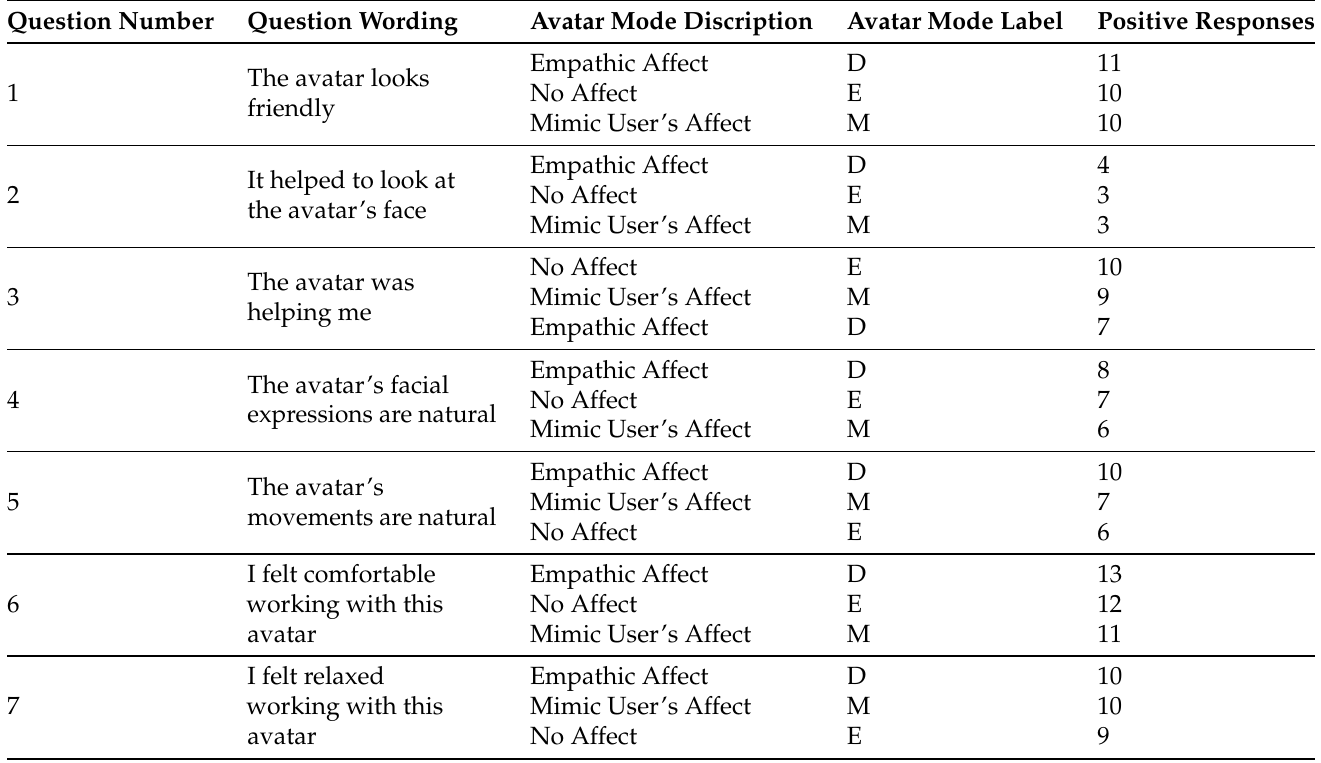
Table 2. Raw count of positive responses in three modes of Diana regarding each